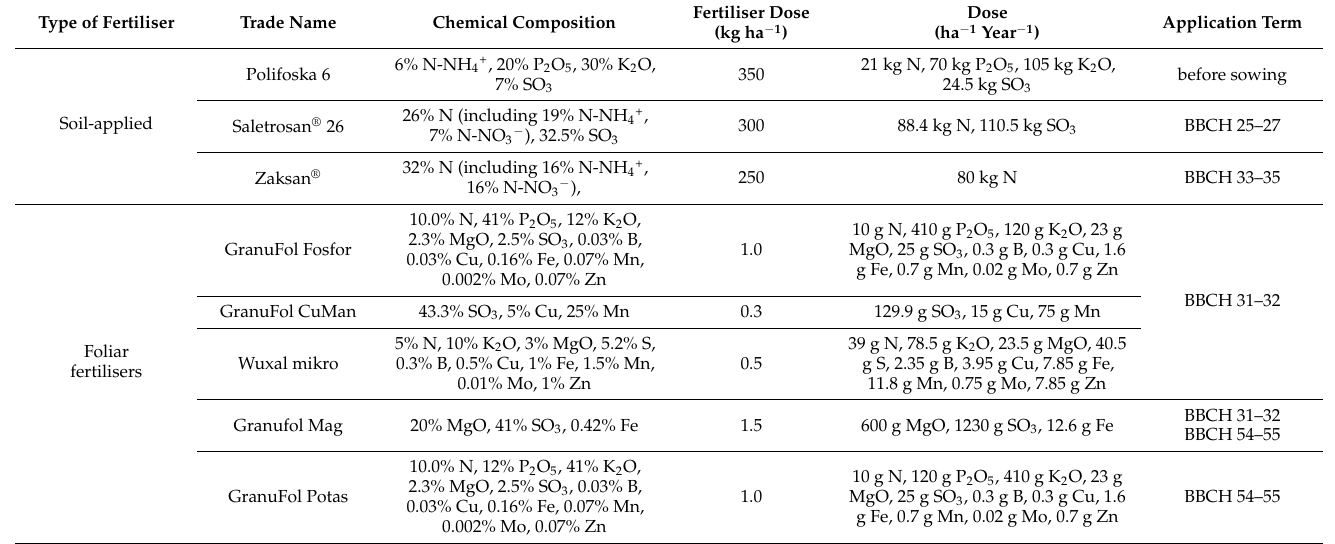
Table 3. Doses and dates of application of